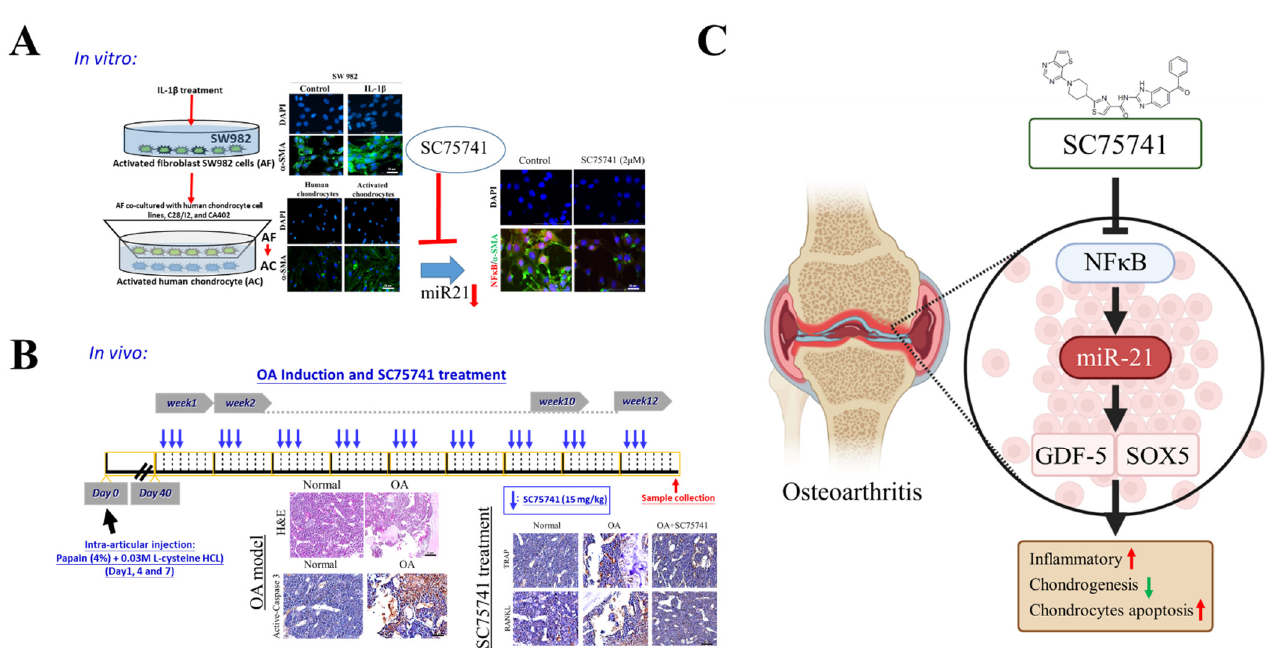
Figure 7. Overall study design. ( A ) Generation of AC cell model through co-culturing the activated fibroblast SW982 in presence of IL-1 β and effect of SC75741 in reduction of miR-21 and NF κ B. ( B ) Schematic representation of the timeline of chemically induced OA and SC75741 treatment. ( C ) Representation of the change in expression of key markers in OA progression and effect of SC75741 treatment. Scale bar = 50 μ m.